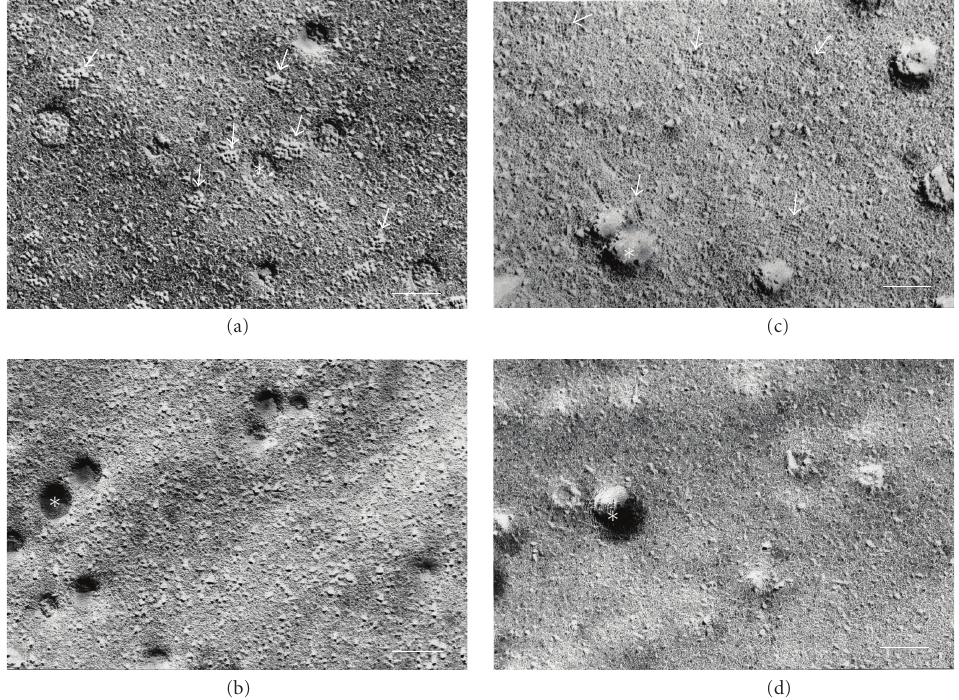
Figure 1: High magnification freeze-fracture view of muscle plasma membrane P faces (a) and (b) and E faces (c) and (d). Normal control muscle contains numerous orthogonal arrays (arrows in (a)) and their pits (arrows in (c)); while Duchenne muscular dystrophy muscle contains apparently no orthogonal arrays (b) and their pits (d). Asterisk in (a)–(d) is caveolae. Scale bar in (a)–(d) = 0.1 μ